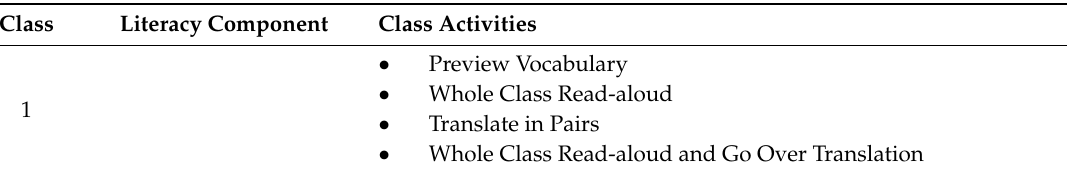
Table A1. A Typical TLC